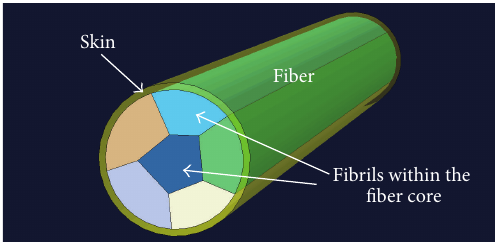
Figure 2: Topological relationship between a single fiber and its constituent